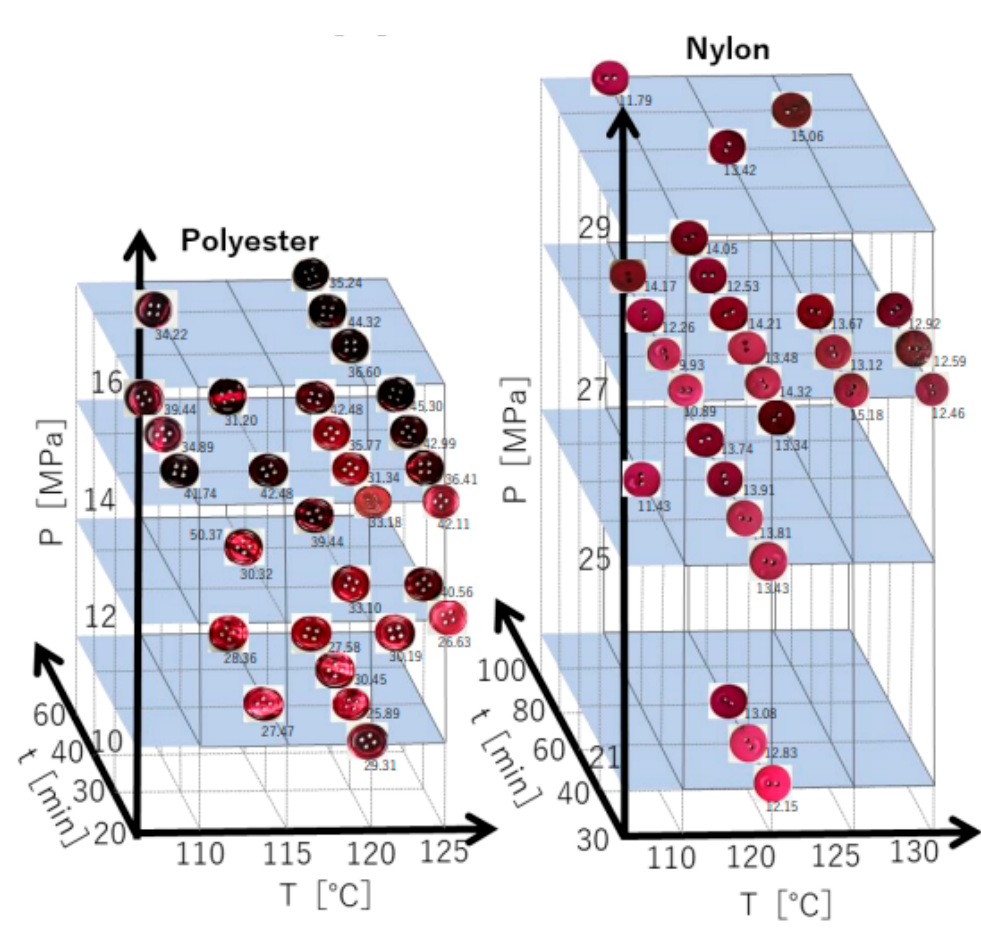
Figure 5. Color change ( K/S ) of acrylic, polyester, nylon, and casein buttons after scCO 2 dyeing.